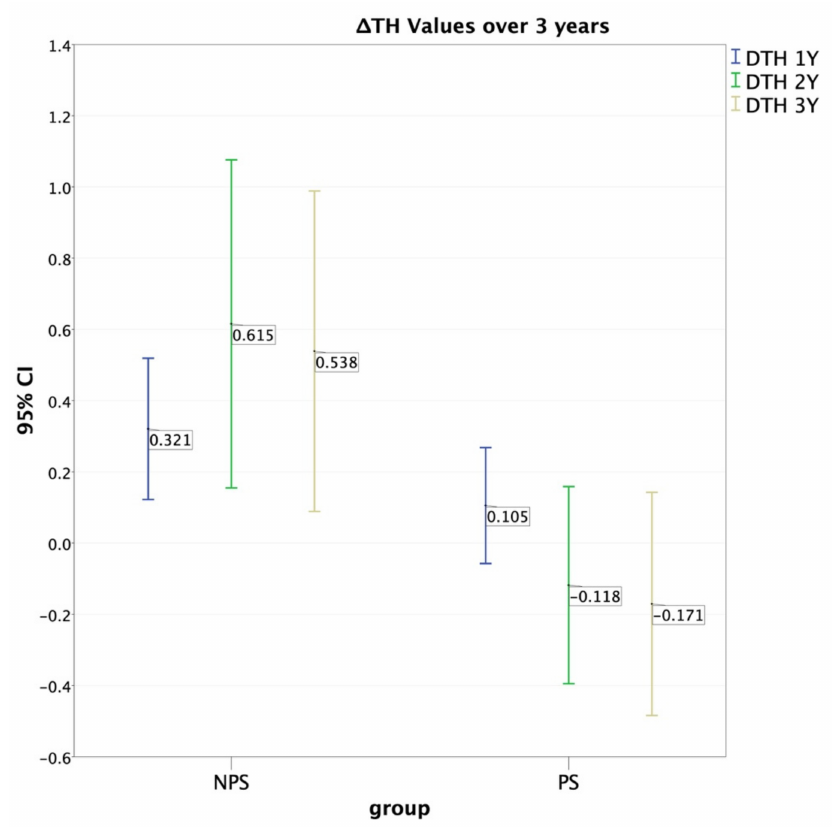
Figure 6. ∆ TH during follow-up period: NPS implants exhibited greater recession when compared to PS implants. Negative values (mm) mean creeping or coronal migration of gingival margin, positive values mean